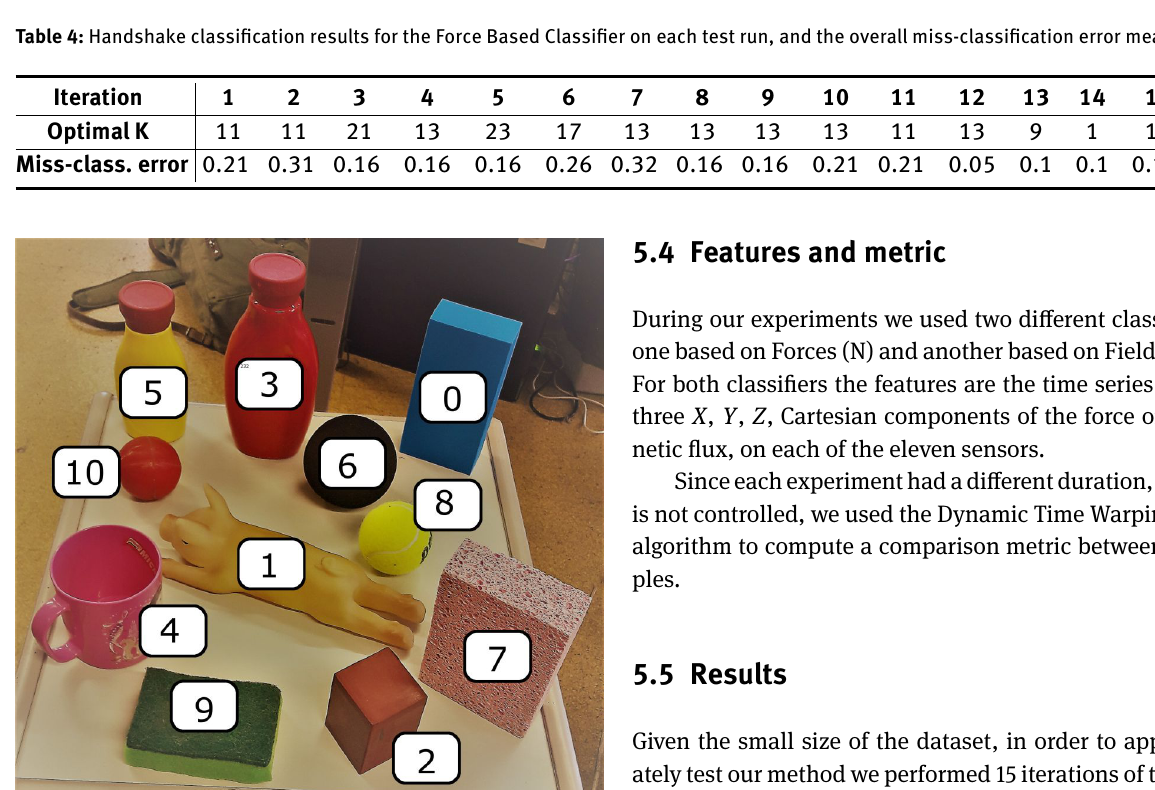
and “strong” empty handshakes in the training set and the medium empty handshake in the test set. The reason for this is to have training data for the special cases where the sensors are not in contact with